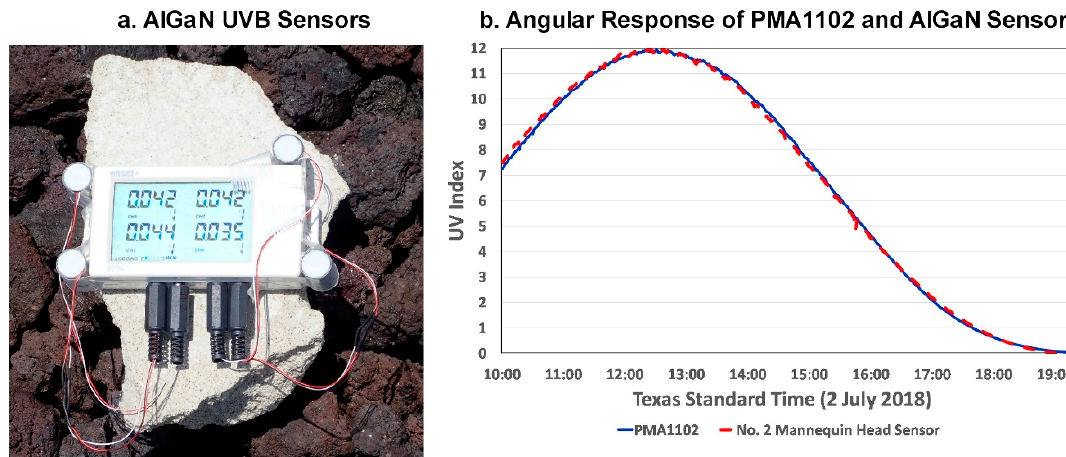
Figure 3. ( a ) Four AlGaN UVB sensors with Teflon™ diffusers temporarily removed from the instrumented mannequin head for a calibration check at the high-altitude (3390 3401 m MSL) Mauna Loa Observatory, and ( b ) Angular response of the PMA1102 UVR sensor and an AlGaN sensor in ( a ).